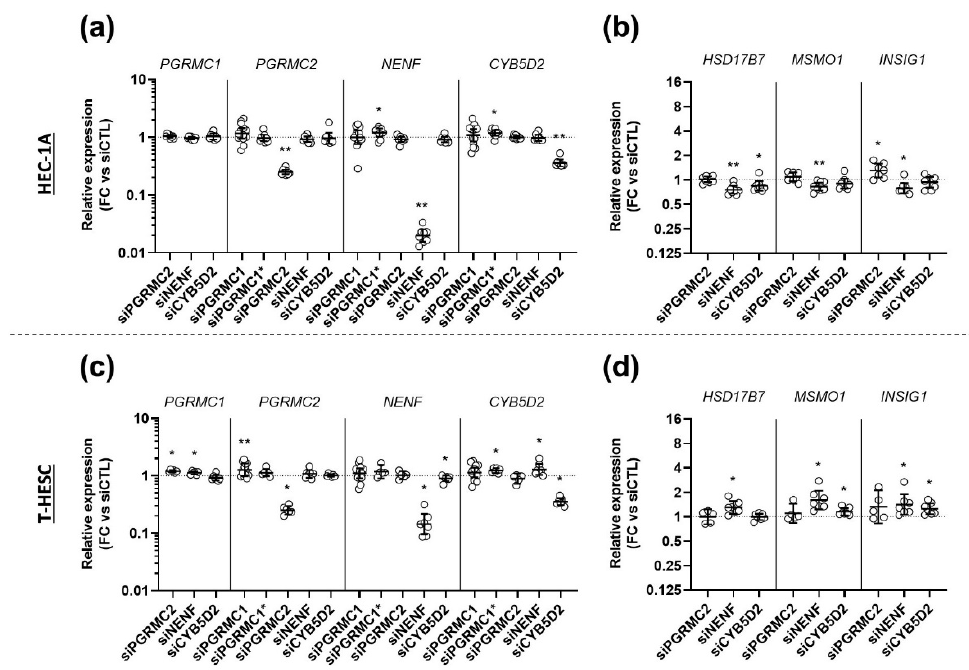
Figure 7. siRNA-mediated down-regulation of PGRMC2, NENF or CYB5D2 expression does not mimic the effect of AG-205 on target genes. HEC-1A ( a , b ) and T-HESC ( c , d ) cells were incubated with 10 nM siRNA-PGRMC1 s21310 (siPGRMC1), siRNA-PGRMC1 18,248 (siPGRMC1*), siRNA-PGRMC2 (siPGRMC2), siRNA-NENF (siNENF), siRNA-CYB5D2 (siCYB5D2) or control siRNA-CTL (siCTL) during 72 h ( n = 4–8). Relative expression of PGRMC1, PGRMC2, NENF and CYB5D2 ( a , c ) and HSD17B7, MSMO1 and INSIG1 ( b , d ) was measured by RT-qPCR, normalized, compared to siRNA-CTL values and is presented as individual fold changes (FC) in log or log2 scale and as geometric means with geometric SD. Statistical test: Wilcoxon paired test, * p < 0.05, ** p < 0.01. Only differences statistically significant by comparison with the control condition (siCTL) are indicated.